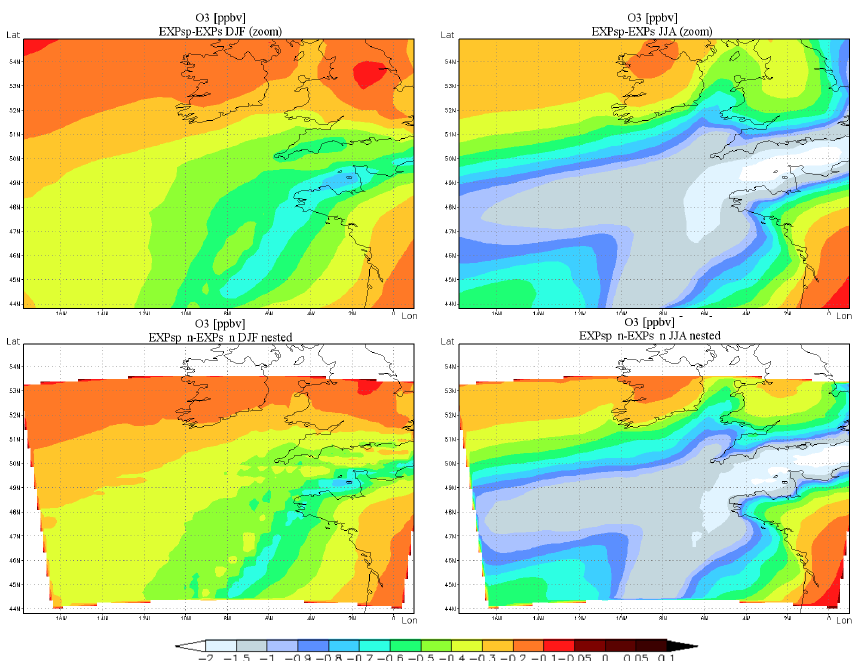
Fig. 13. Sensitivity test on model resolution. Top row: difference of surface O 3 of experiments EXPsp and EXPs zoomed on the nested 10km domain. In the lower row: difference of EXPsp n and EXPs n. Concentrations are in ppbv, left column for winter, right column for summer